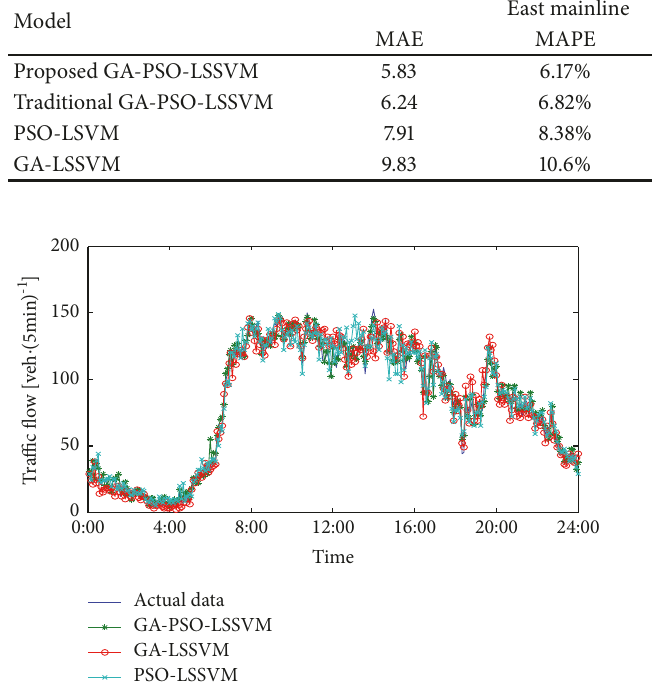
Figure 12: The comparative analysis for detector NBDX11 (1) .